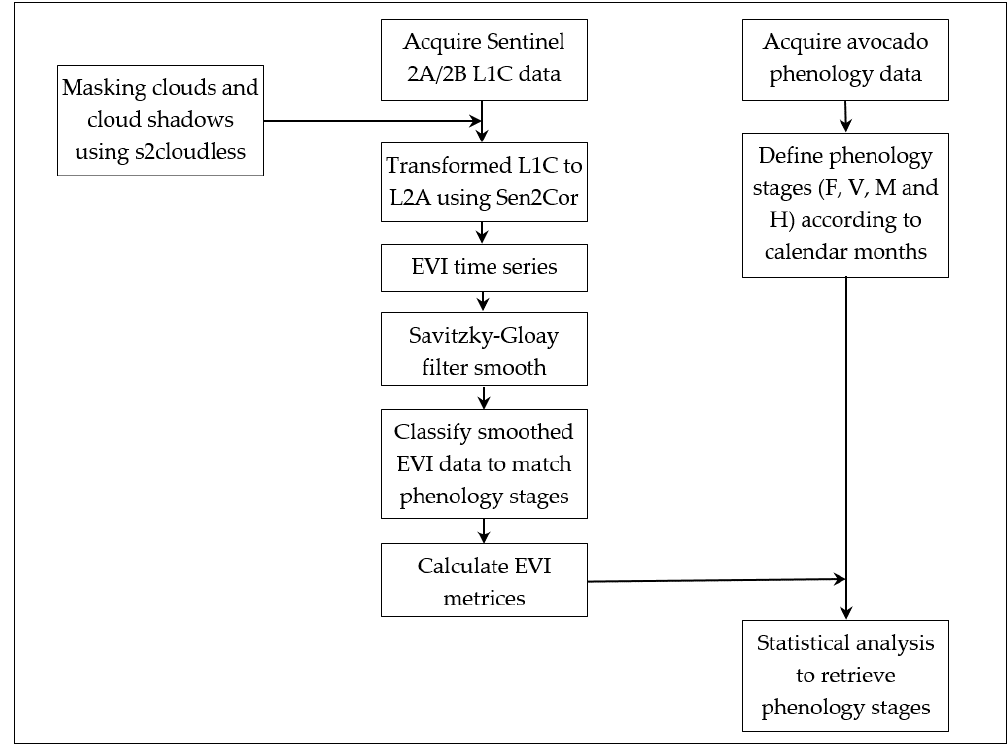
Figure 4. The workflow for monitoring avocado crop phenological stages using time-series Sentinel 2 images.